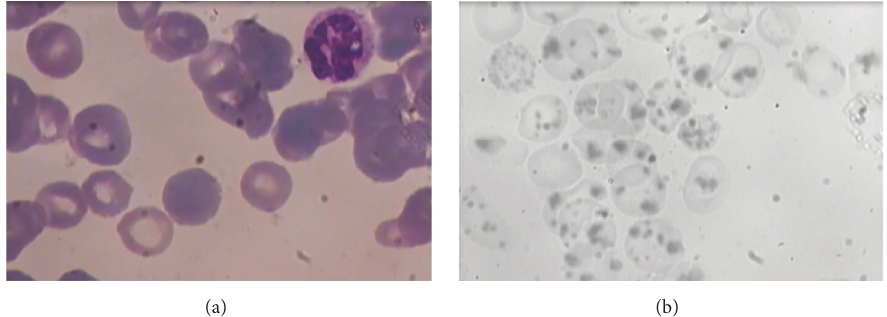
Figure 1: (a) Peripheral blood smear. A hypersegmented neutrophil is found on the right upper corner of the picture. (b) Peripheral blood smear depicting abundant Heinz bodies in our patient with hemoglobin H